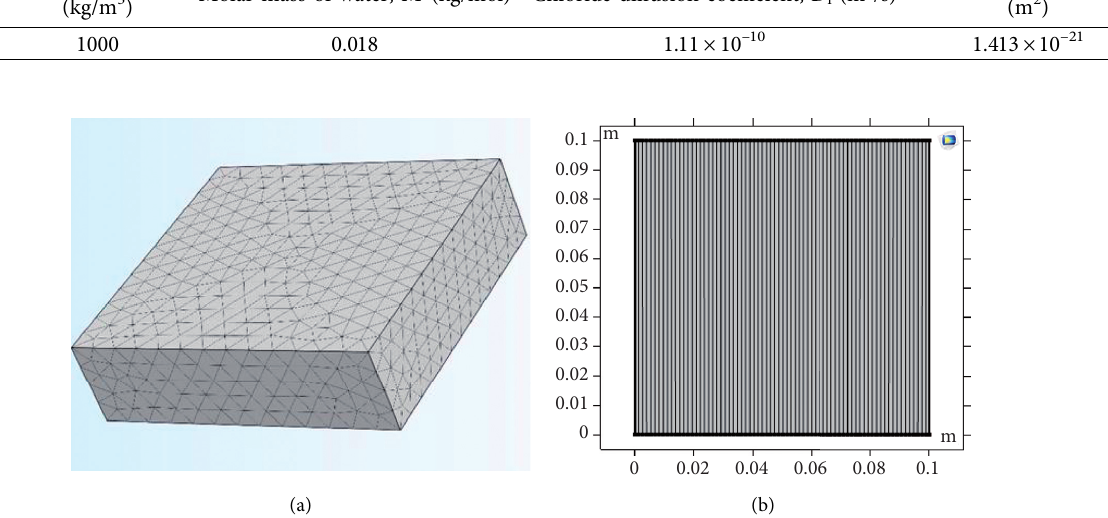
Figure 6: The finite element model of concrete: (a) moisture transport model and (b) chloride transport model.